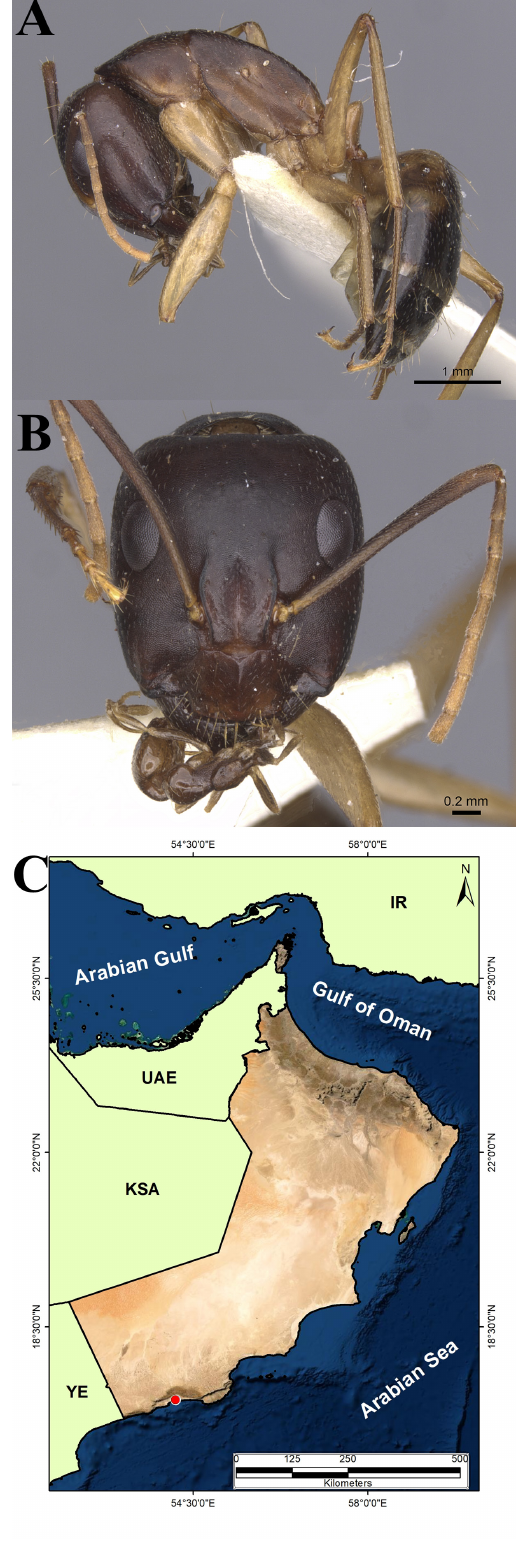
Fig. 5. Camponotus arabicus Collingwood, 1985, paratype, major worker (CASENT0911902, AntWeb.org (Will Ericson)). A . Body in profile. B . Head in full-face view. C . Distribution